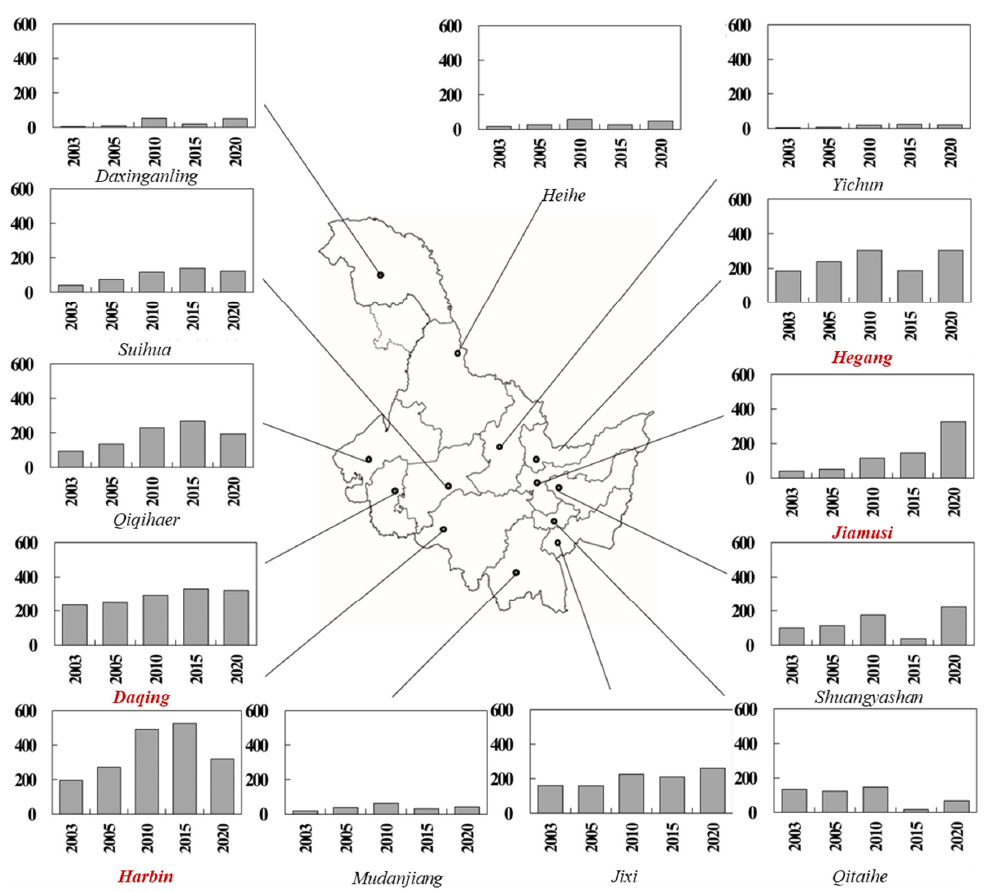
Figure 3. Spatial distribution of CH 4